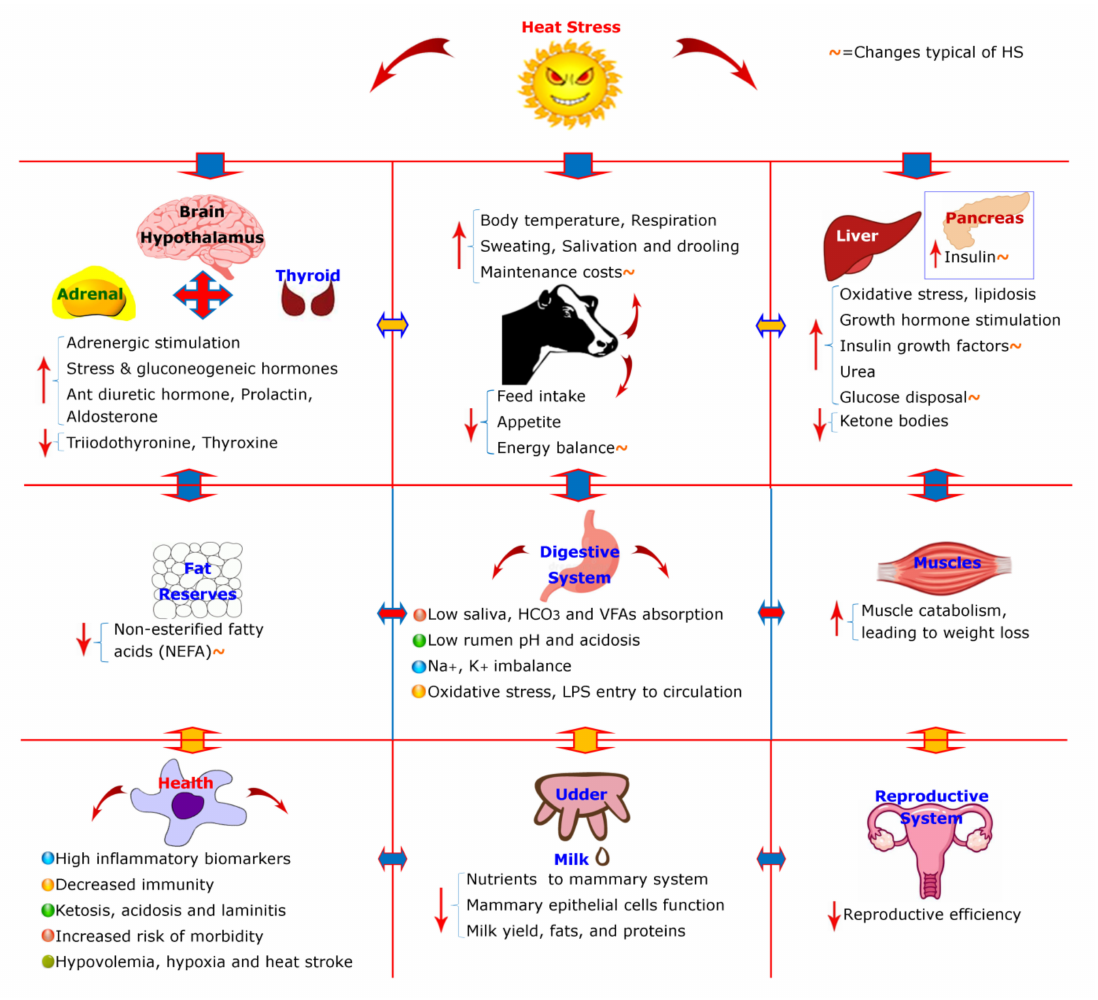
Figure 1. Summary of various heat stress-related physiological and biochemical changes occurring at various systems level in the body of the dairy cows. Phrases with the indication of “~” indicate changes typical of heat stressed animals. (LPS = lipopolysaccharides, VFAs = volatile fatty